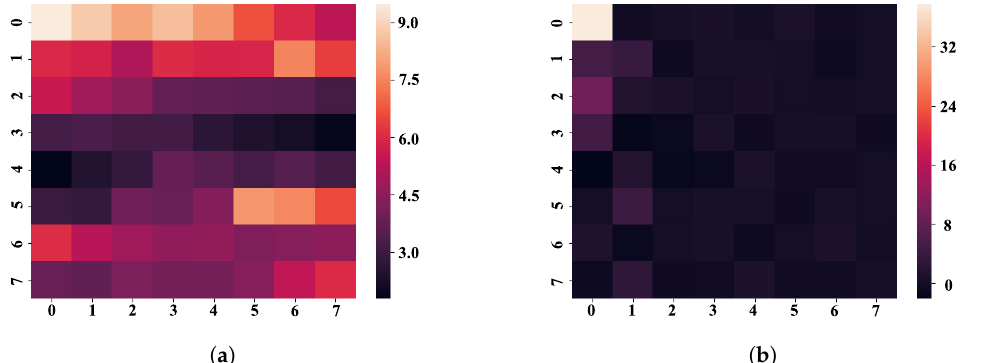
Figure 7. Data aggregation comparison chart. ( a ) Data thermal distribution of the original matrix. ( b ) Data heat distribution of the aggregation